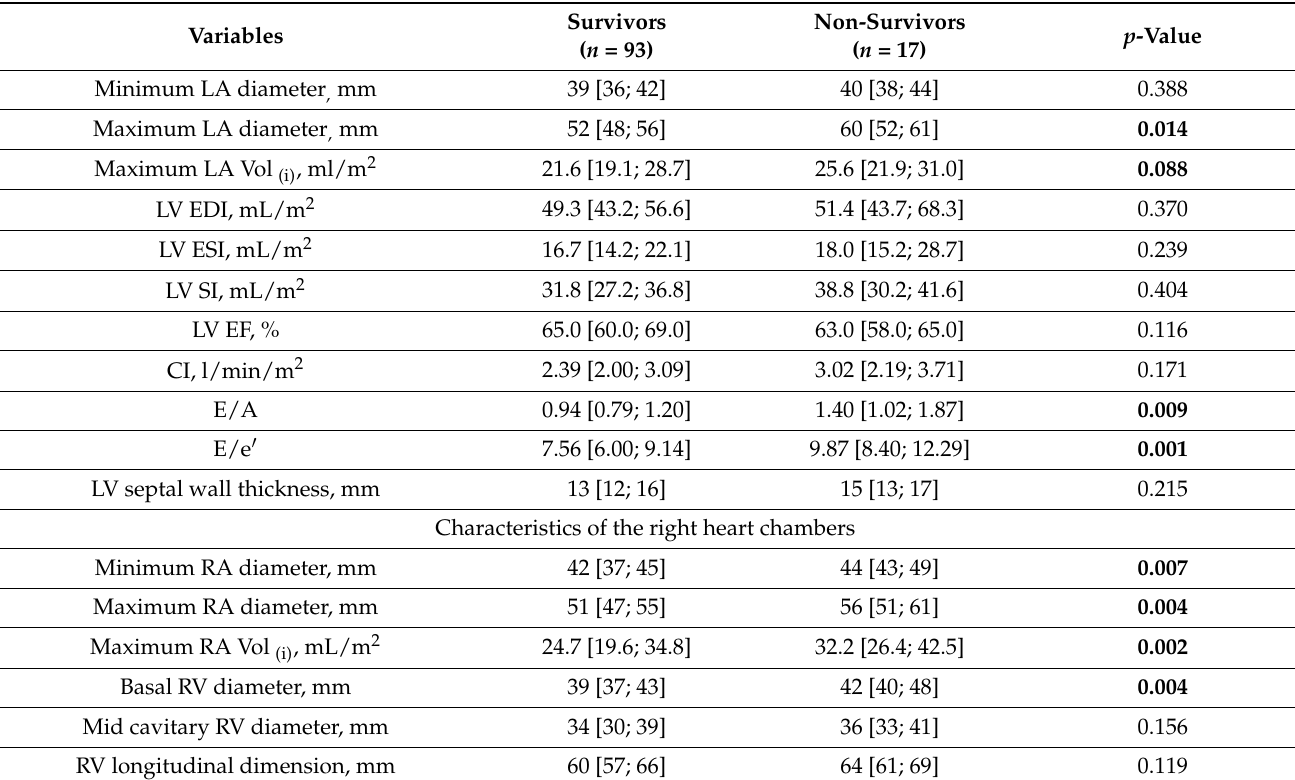
Table 3. Echocardiography of patients with COVID-19